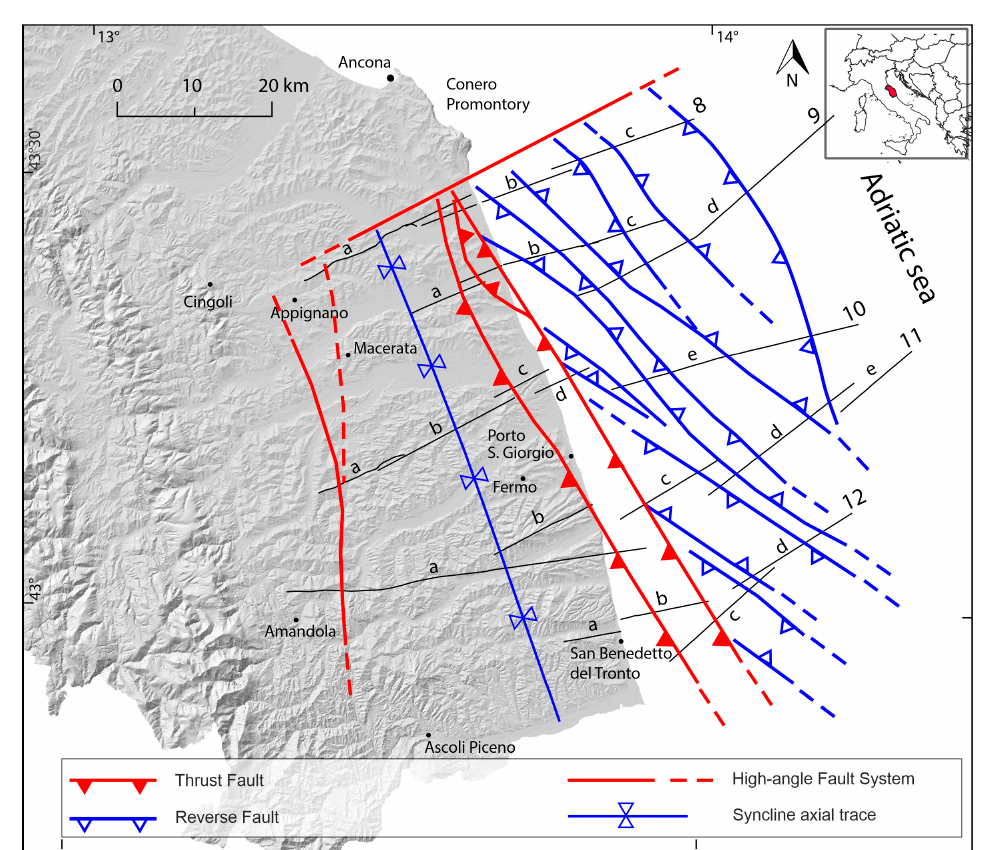
Figure 10. Structural sketch map of the outer Marche area south of Conero promontory. The main Plio–Quaternary structures are highlighted.